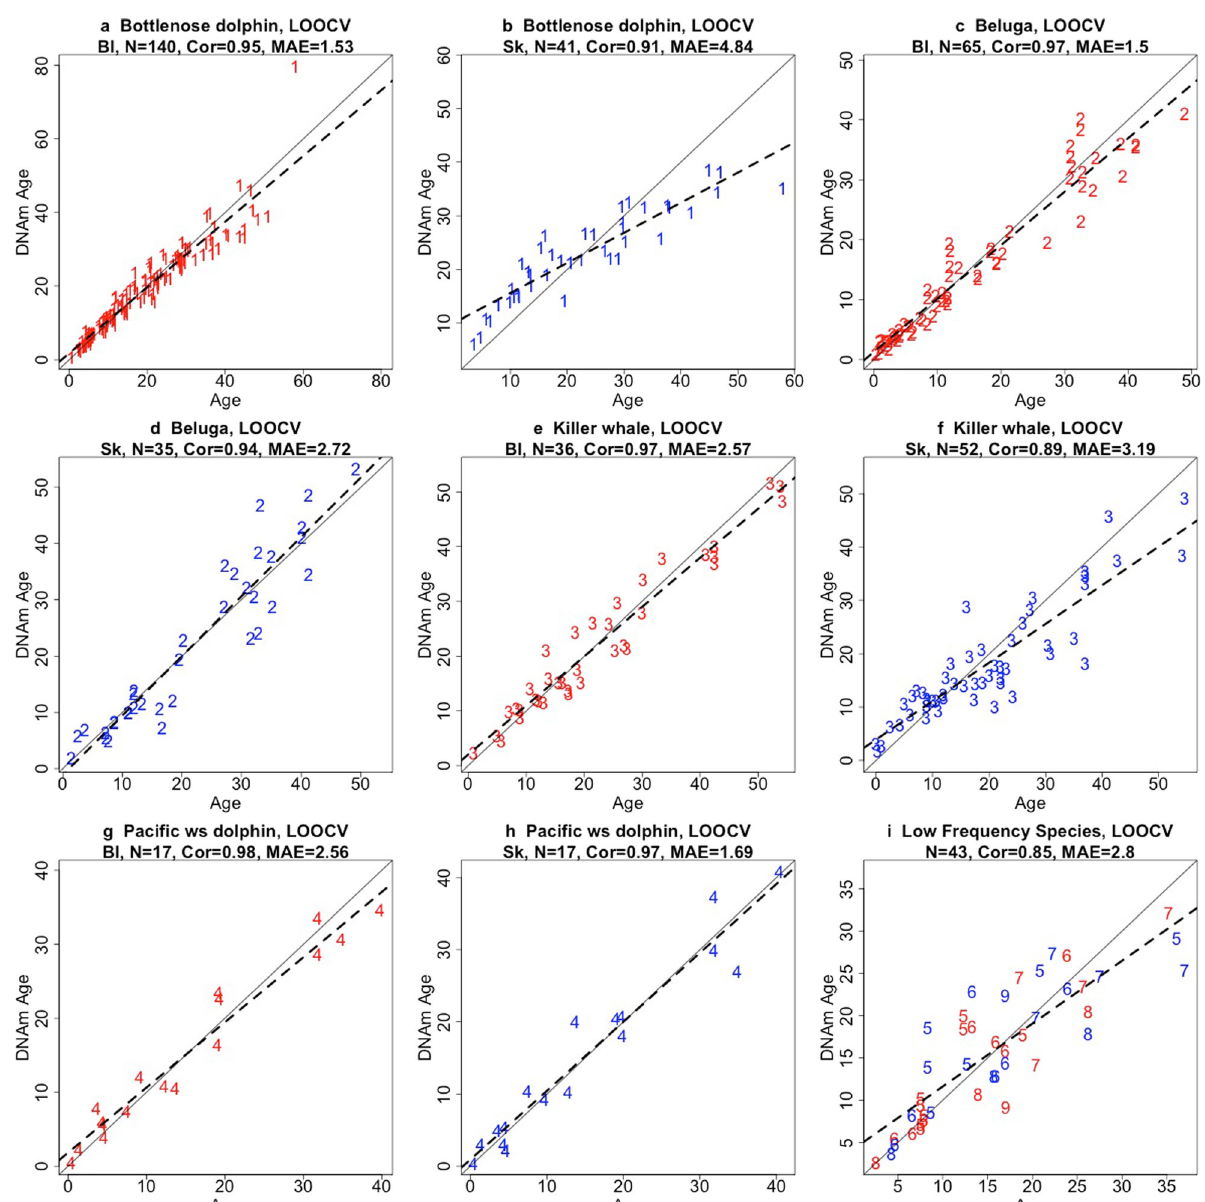
Fig. 2 Cross-validation (LOOCV) study of the odontocete blood + skin clock (OEAC) applied to skin and blood samples collected from individual species. Each panel reports leave-one-out (LOOCV) estimates of the odontocete clocks applied to blood and skin samples from each species: bottlenose dolphin ( a , b ); beluga ( c , d ); killer whale ( e , f ); Paci fi c white-sided (ws) dolphin ( g , h ); and low frequency species ( i ). Dots are colored by tissue type (red = blood, blue = skin). Numbers denote different species: 1 = bottlenose dolphin ( Tursiops truncatus ); 2 = beluga ( Delphinapterus leucas ); 3 = killer whale ( Orcinus orca ); 4 = Paci fi c white-sided dolphin ( Lagenorhynchus obliquidens ); 5 = short- fi nned pilot whales ( Globicephala macrorhynchus ); 6 = rough-toothed dolphin ( Steno bredanensis ); 7 = Commerson ’ s dolphin ( Cephalorhynchus commersonii ); 8 = common dolphin ( Delphinus delphis ); and 9 = harbor porpoise ( Phocoena phocoena ). Each panel depicts a linear regression line (black dashed line), a diagonal line (y = x), the sample size ( N ), Pearson correlation (Cor), and median absolute error (MAE) across all